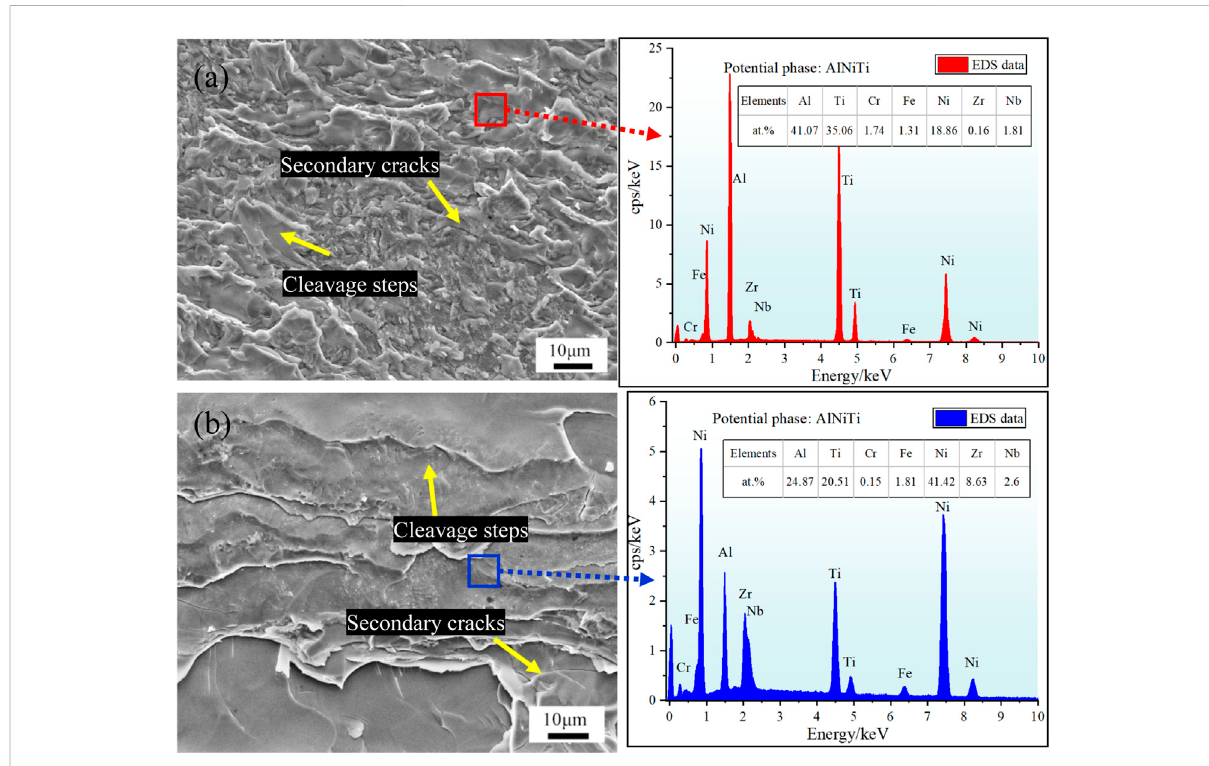
FIGURE 11 Fracture morphologies of the joint brazed at 1090 ° C tested at (A) room temperature and (B) 750 °